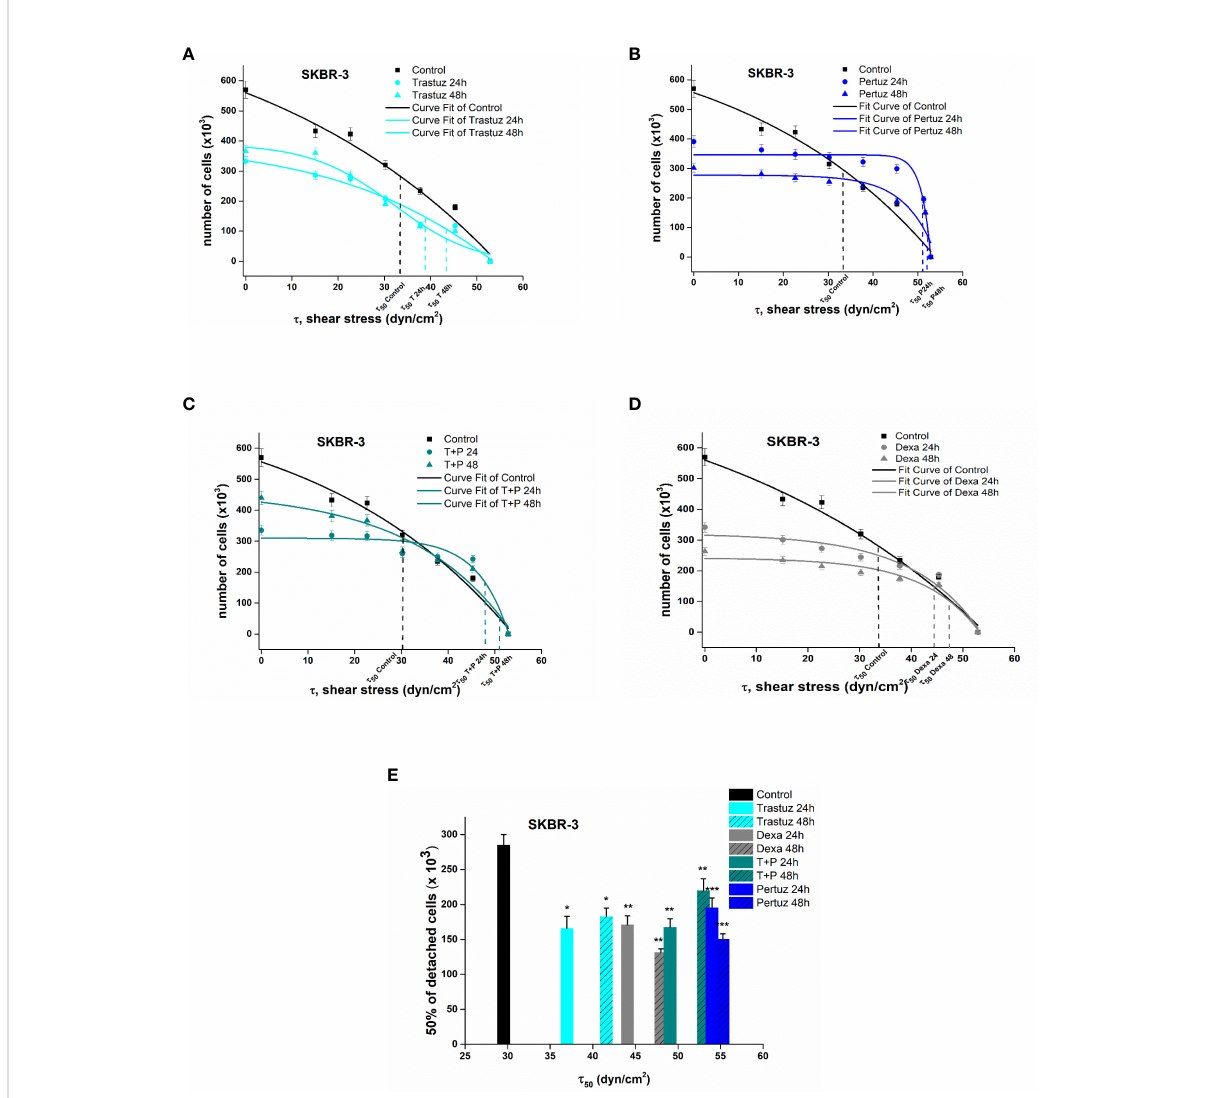
FIGURE 6 Plotted curves of the number of remaining SKBR-3 cells post detachment event vs the essential shear stress for detachment (A – D) . The applied shear stress is zero to attached cancer cell upon the center of the disc (r = 0) where the remained cells after detachment are 100%, no detachment was occurred and maximum when r = R disc = 1 cm where all cancer cells where detached. Percentage number of remaining cells of control and treated SKBR-3 breast cancer cells upon the collagen coated surface after applying a range of 0 – 200 dyn/cm 2 shear stresses (E) . Data express mean values ± SD of at least three repeated experiments, *p <0.05, **p <0.01, and ***p